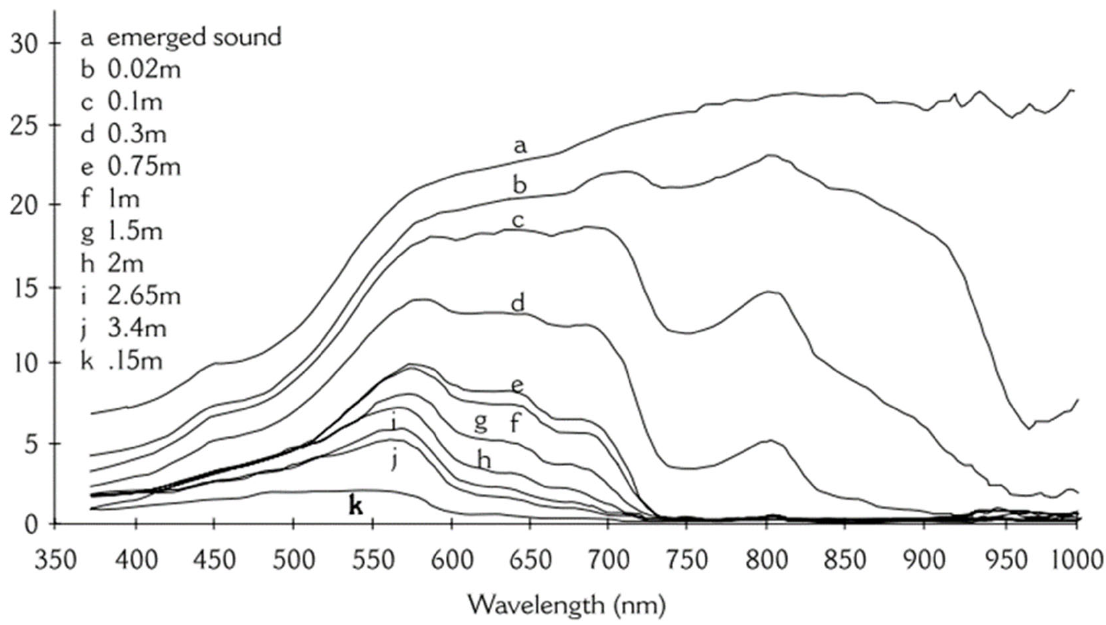
Figure 12. Reflectance spectra of water at different depths [309].